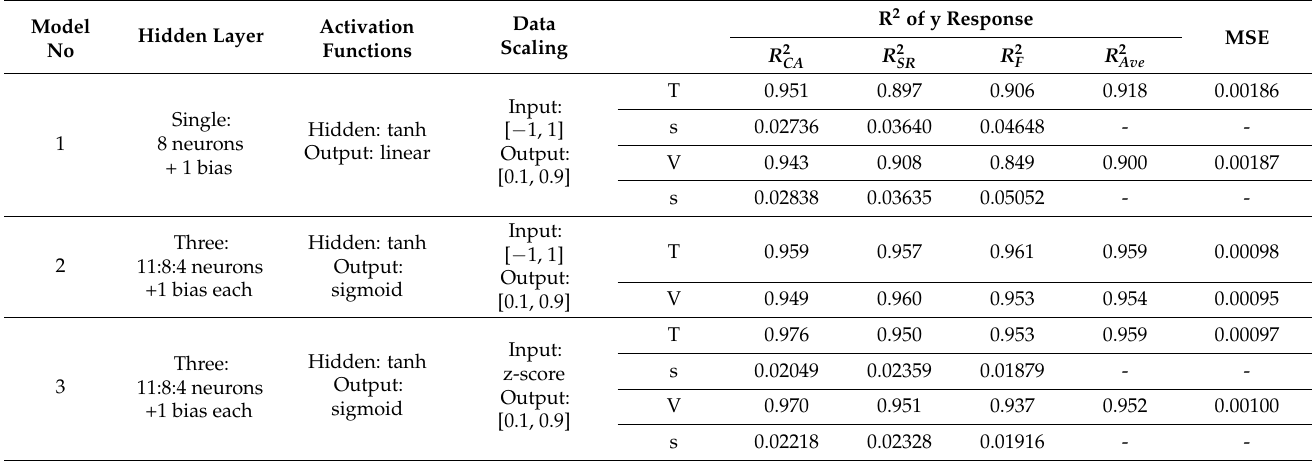
Table 3. ANN regression analysis performances.